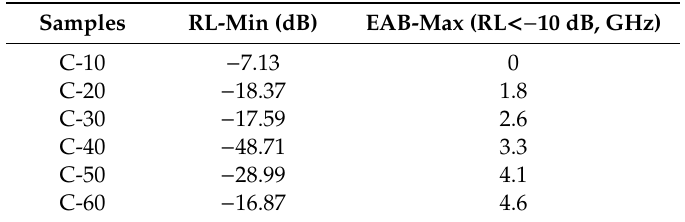
Table 3. EMW absorption properties of samples C-10, C-20, C-30, C-40, C-50, and C-60. EAB: e ff ective absorption